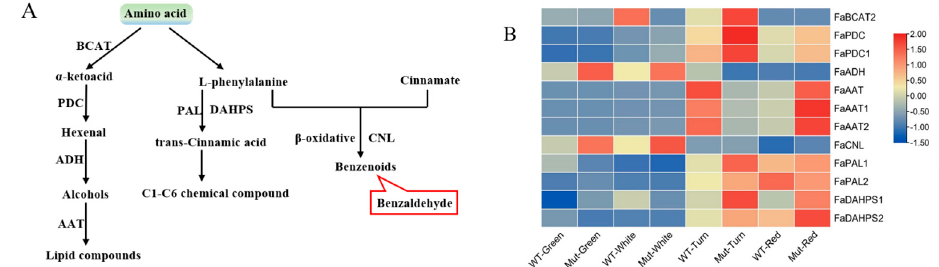
Figure 7. ( A ) Amino acid pathway. The red squares represent volatile components that play a major role in strawberry aroma presentation (i.e., OAV values greater than 1). BCAT is branched-chain aminotransferase; PDC is pyruvate decarboxylase isozyme; ADH is alcohol dehydrogenase; AAT is alcohol acyltransferase; DAHPS is phospho-2-dehydro-3-deoxyheptonate aldolase; PAL is phenyl- alanine ammonia lyase; CNL is CoA ligase. ( B ) Expression analysis of biosynthetic genes involved in amino acid pathway of ‘Sachinoka’ strawberry and its somaclonal mutant ‘Mixue’ fruit at four developmental stages: BCAT is branched-chain aminotransferase; PDC is pyruvate decarboxylase isozyme; ADH is alcohol dehydrogenase; AAT is alcohol acyltransferase; DAHPS is phospho-2-de- hydro-3-deoxyheptonate aldolase; PAL is phenylalanine ammonia lyase; CNL is CoA ligase. ER: endoplasmic reticulum. WT represents cultivated strawberry ‘Sachinoka’. Mut represents somaclonal mutant ‘Mixue’.